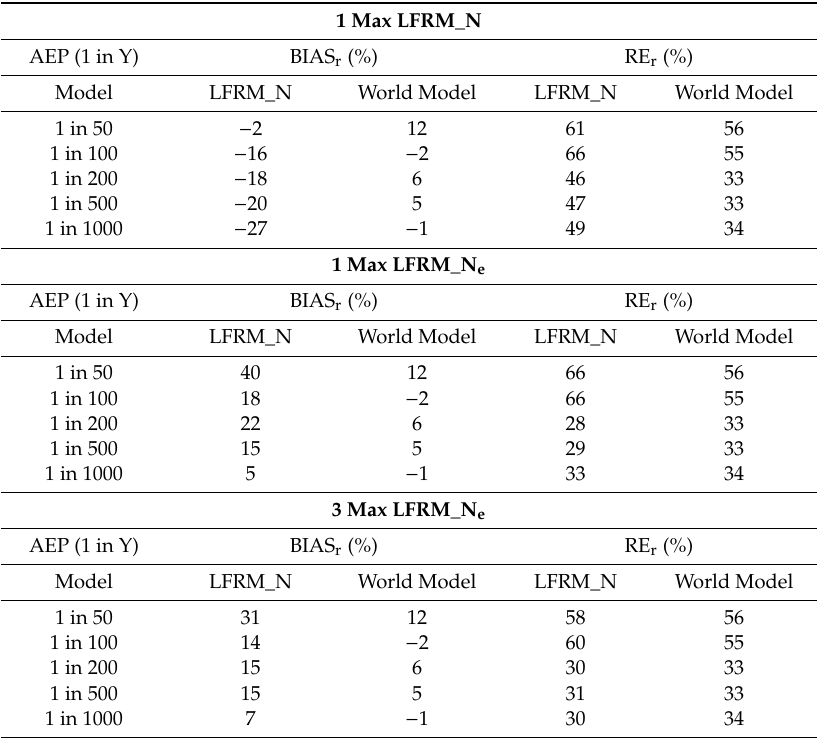
Table 5. Summary of error statistics obtained from independent testing associated with the large flood regionalisation model (LFRM)